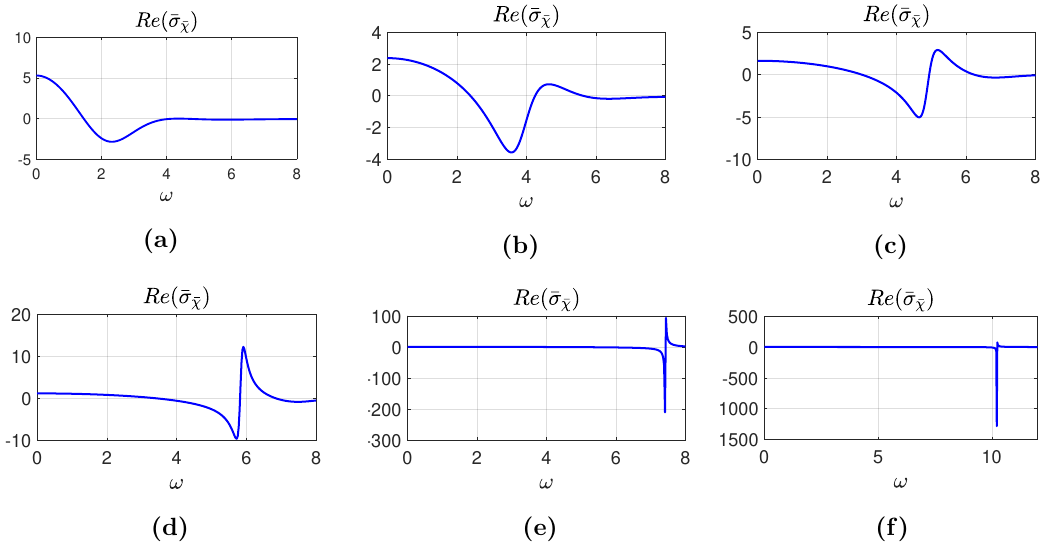
Figure 11. Re ((cid:22) (cid:27) (cid:22) (cid:31) ) as a function of ! when q = 0 and (a) (cid:20) B = 0 : 1, (b) (cid:20) B = 0 : 4, (c) (cid:20) B = 0 : 6, (d) (cid:20) B = 0 : 8,(e) (cid:20) B = 1 : 2, (f) (cid:20) B = 2 : 2.